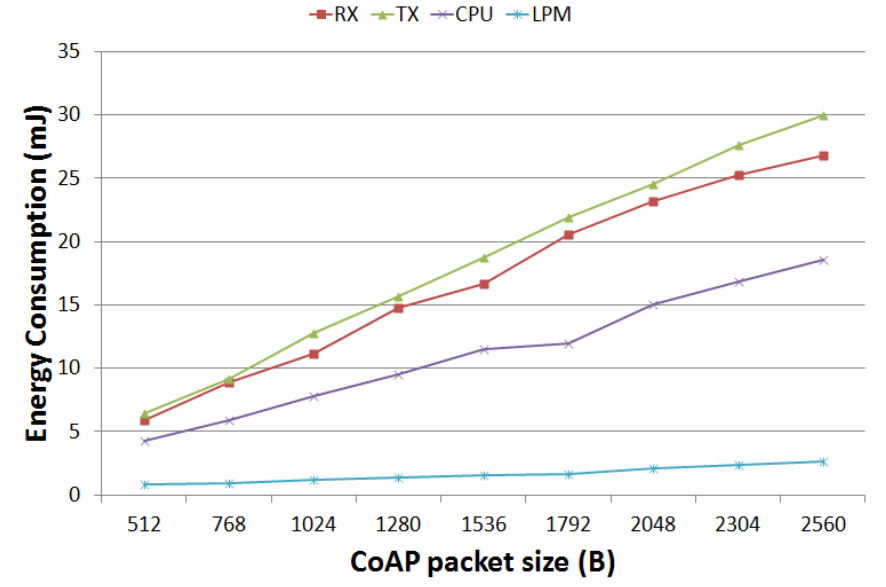
Figure 8. Energy Consumption as a function of the CoAP Packet